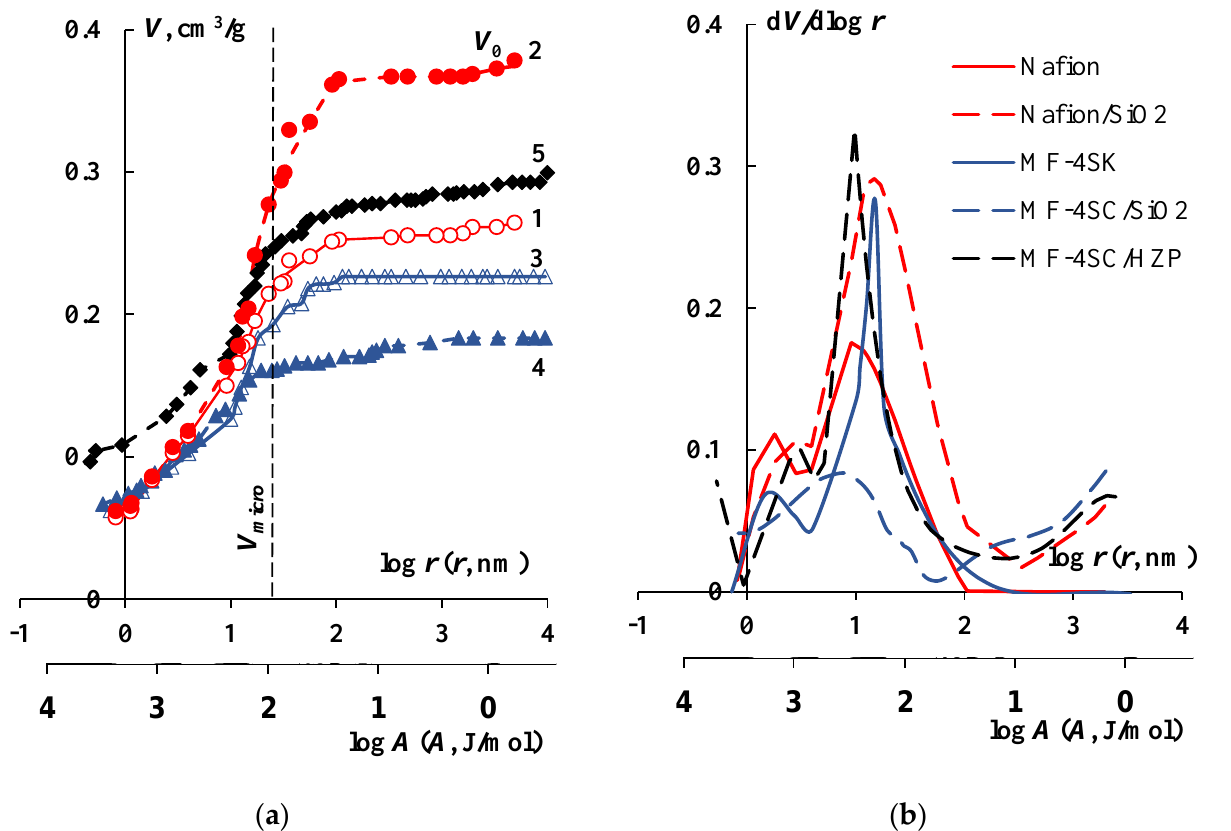
Figure 2. Integral ( a ) and differential ( b ) functions of water distribution on the water binding energy and the effective pore radii for the initial (1, 3) and modified (2, 4, 5) membranes: 1 — Nafion; 2 — Nafion/SiO 2 ; 3 — MF-4SK; 4 — MF-4SK/SiO 2 ; 5 —МF - 4SК/HZP . Table 1. Physicochemical characteristics of initial and modified perfluorinated membranes.